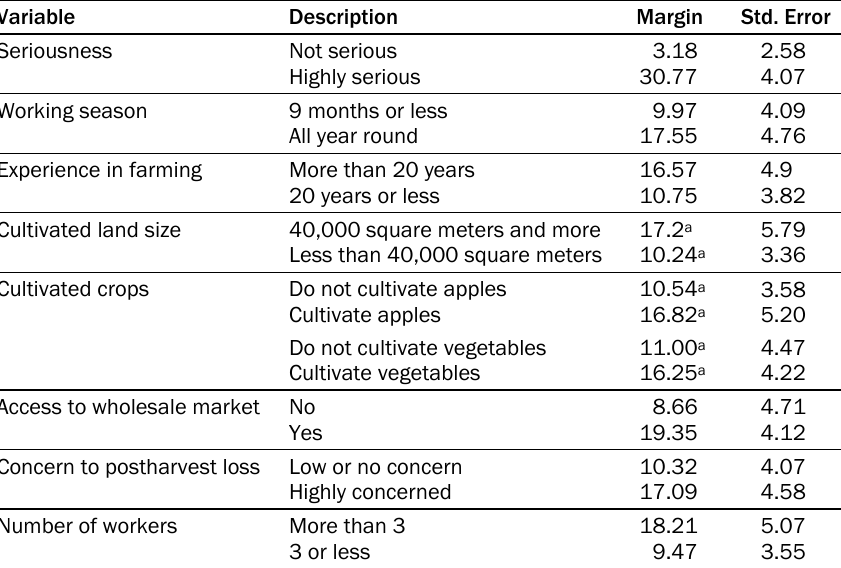
Table 5. Expected WTP Values at Various Covariate Levels